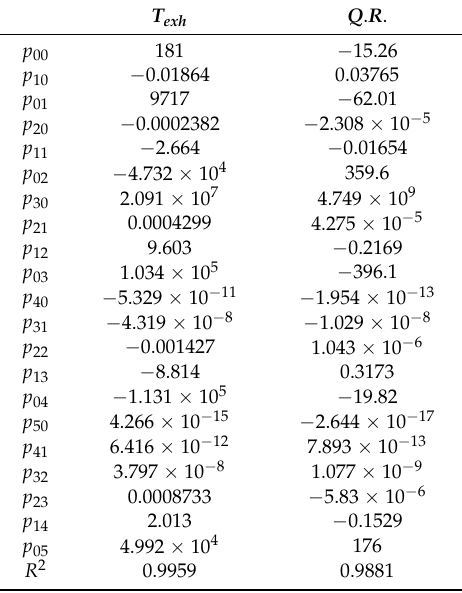
Table A1. Coefficients of the 5th order polynomial surface fits on T exh and Q . R